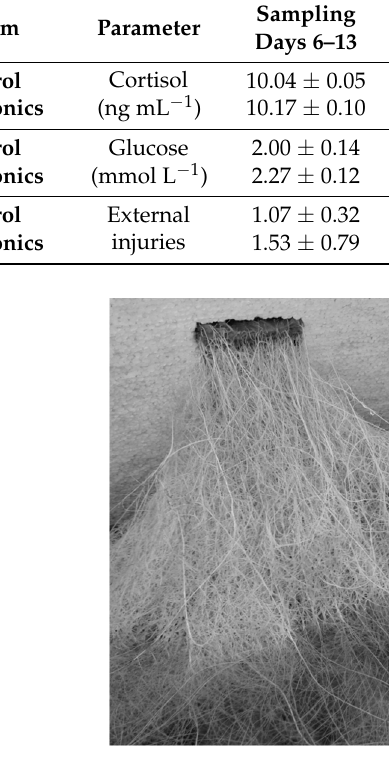
Figure A1. Root meshes of cucumber plants ( C. sativus ) in the final phase of the experiment.